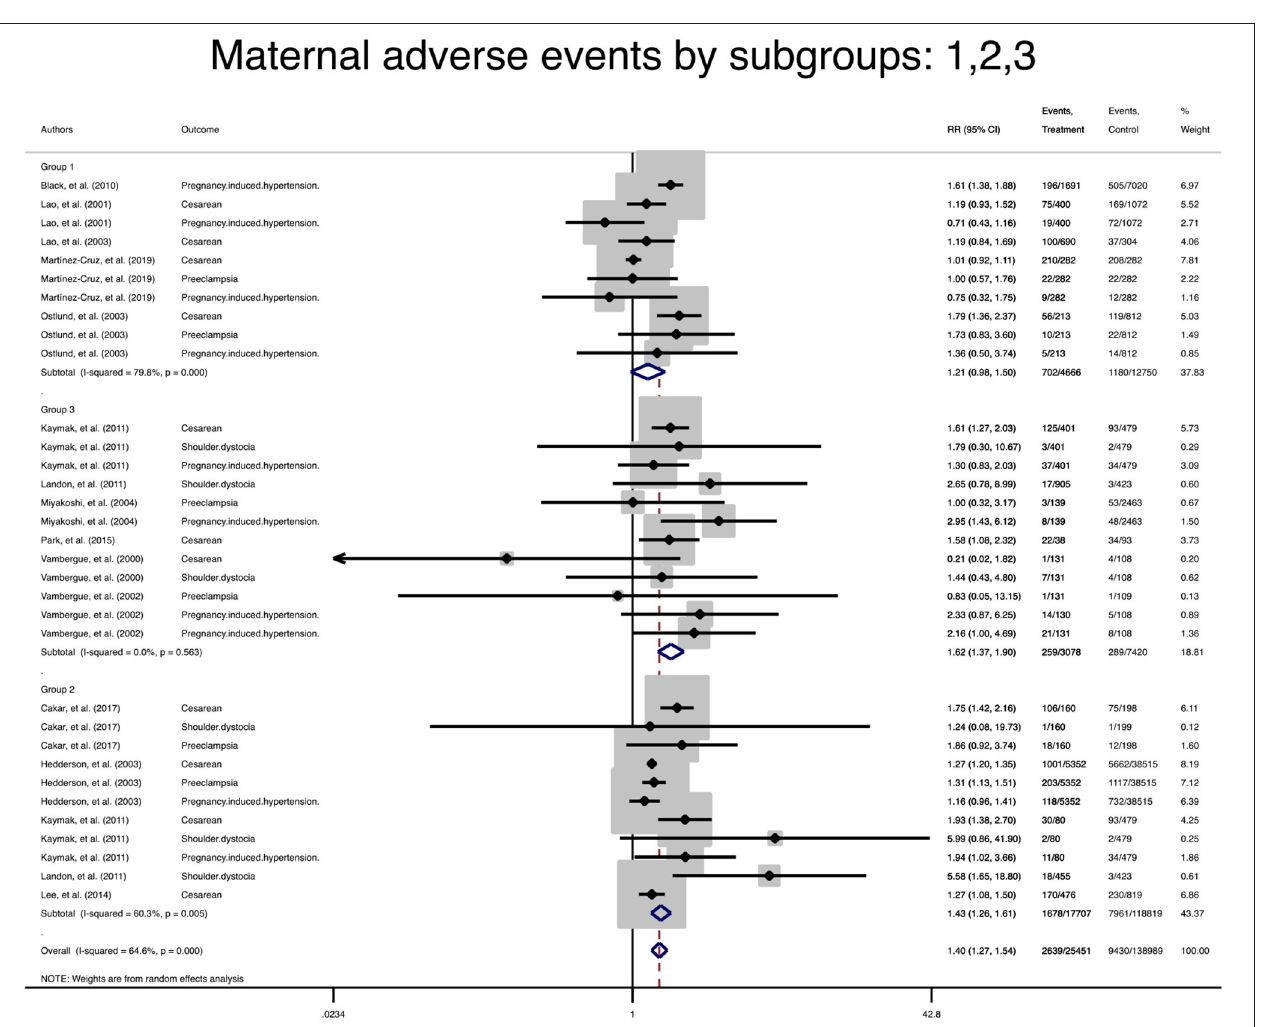
Frontiers in Medicine |